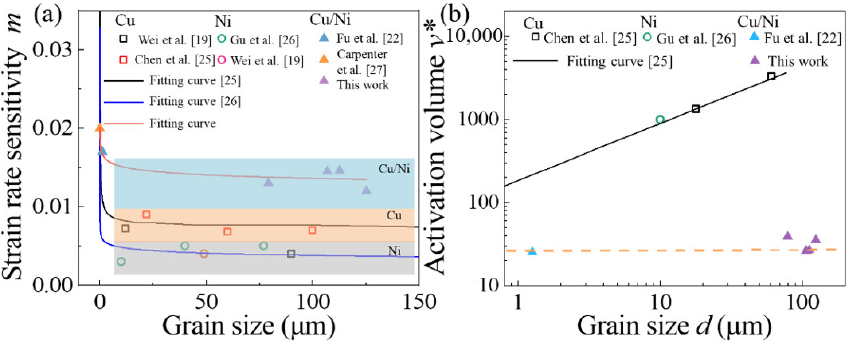
Figure 8. ( a )Variation of m ; ( b ) variation of v * as a function of d for Cu, Ni, and Cu/Ni clad foils using experimental data from prior papers and the present work.